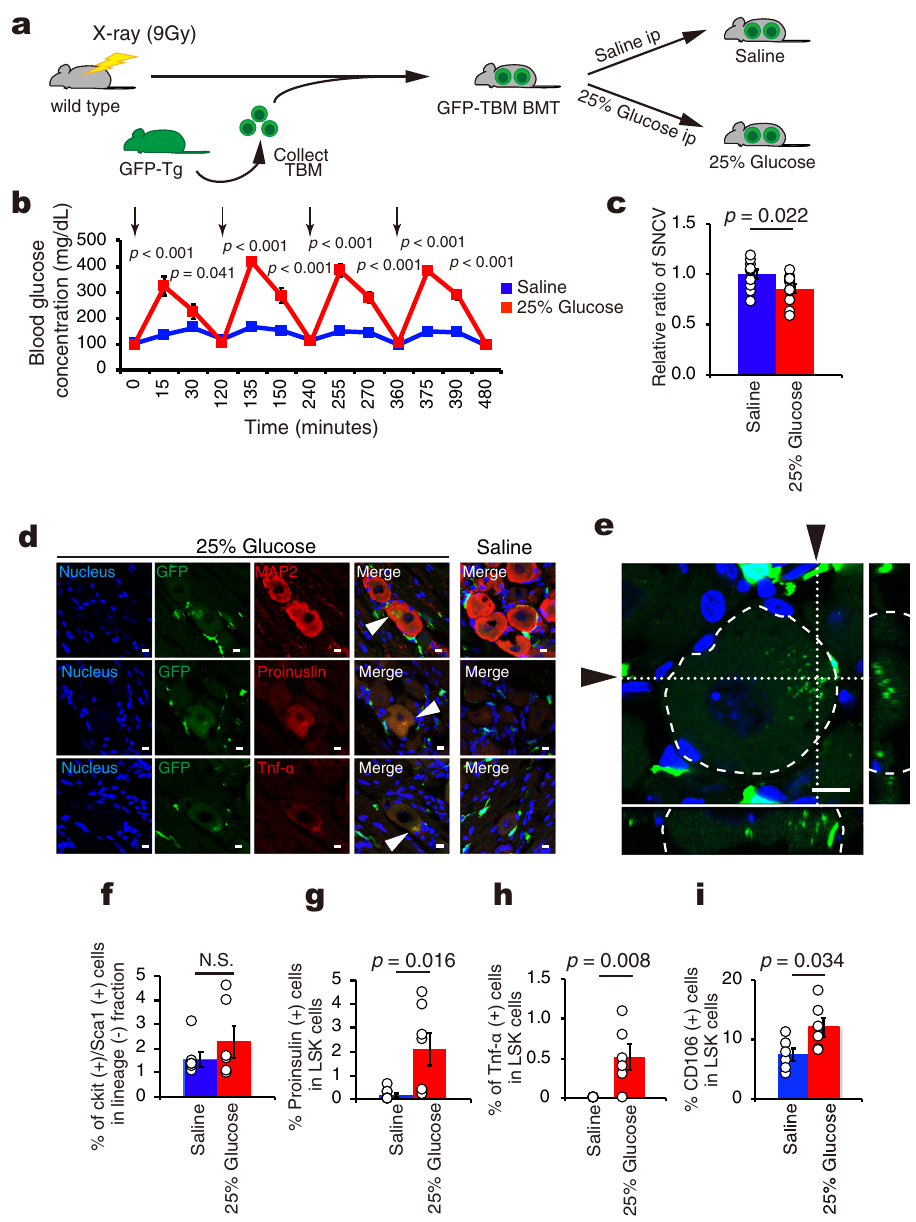
Fig. 8 Cell fusion and development of diabetic neuropathy in wild mice injected intraperitoneally with 25% glucose. a A schematic experimental design for the generation of 25% glucose- (25% Glucose) or saline- (Saline) injected wild type mice transplanted total bone marrow cells (TBM) from GFP-Tg (GFP-TBM BMT). ip, intraperitoneal injection. b The time course of blood glucose concentrations in GFP-TBM BMT mice treated with repeated intraperitoneal injection four times every two hour for 14 days. Arrows indicate timings of intraperitoneal injections (Saline n = 11, 25% Glucose n = 12). Red line indicates the effect of 25% glucose injection whereas blue line shows that of saline. c Relative ratio of SNCV of sciatic nerve in Saline ( n = 11) compared to that in 25% Glucose ( n = 12). d Immuno fl uorescent staining of dorsal root ganglion (DRG) for nucleus (blue), GFP (green), MAP2 (red), proinsulin (red), and TNF- α (red), and merged fi gures. Left panel shows the effects of 25% Glucose and right panel shows that of Saline. Arrowheads showed fusion cell. Scale bars = 10 μ m. e Z-stack imaging of DRG from 25% Glucose. Narrow images indicate the cross-section of x -axis or y -axis (whited dotted line) in DRG neuron surrounded by white dashed line. Arrows indicate the position of cross-section. Green showed GFP. Blue showed nucleus. Scale bar = 10 μ m. f The effect of injection of either Saline or 25% Glucose on the percentage of LSK cells in mononuclear cell fraction from total bone marrow. Percentage of LSK cells in the mononuclear cell fraction from total bone marrow in Saline and 25% Glucose ( n = 6 per group). g Percentage of proinsulin- positive cells in LSK cells from Saline and 25% Glucose ( n = 7 per group). h Percentage of TNF- α -positive cells in LSK cell fraction from mononuclear cell in Saline and 25% Glucose ( n = 6 per group). i Percentage of CD106-positive cells in LSK cell fraction from mononuclear cell ( n = 6 per group). Data are indicated as means ± episodic glucose injections is suf fi cient to induce cell fusion between BMDCs and neurons.